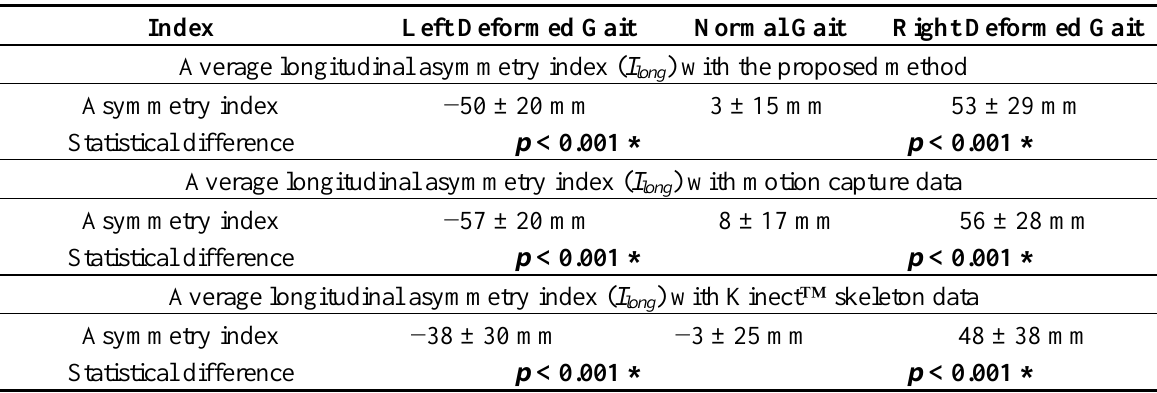
Table 2. Total asymmetry index results for the average longitudinal asymmetry index ( I long ) computed with different methods for normal, left deformed and right deformed gait. The results are reported with the mean value and the standard deviation. Significant statistical results are written in bold and marked with * when p < 0.001. An I long value close to zero indicates perfect symmetry of the gait.